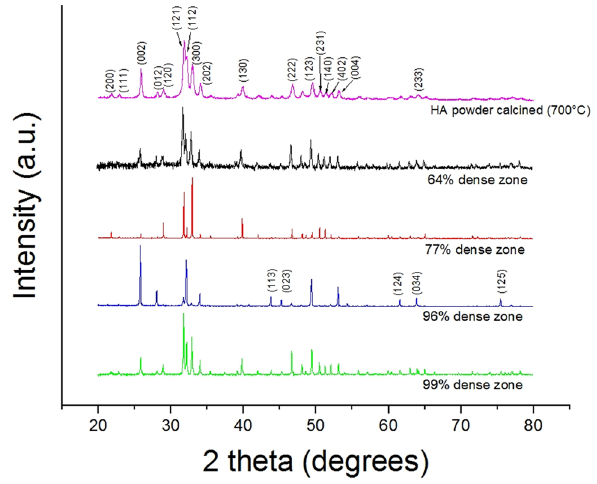
Figure 9: XRD patterns of di ff erent zones along the extruded HA monolith. The XRD pattern of the calcined HA powder is included as reference. Preferential crystal orientation is observed in the extruded zone.